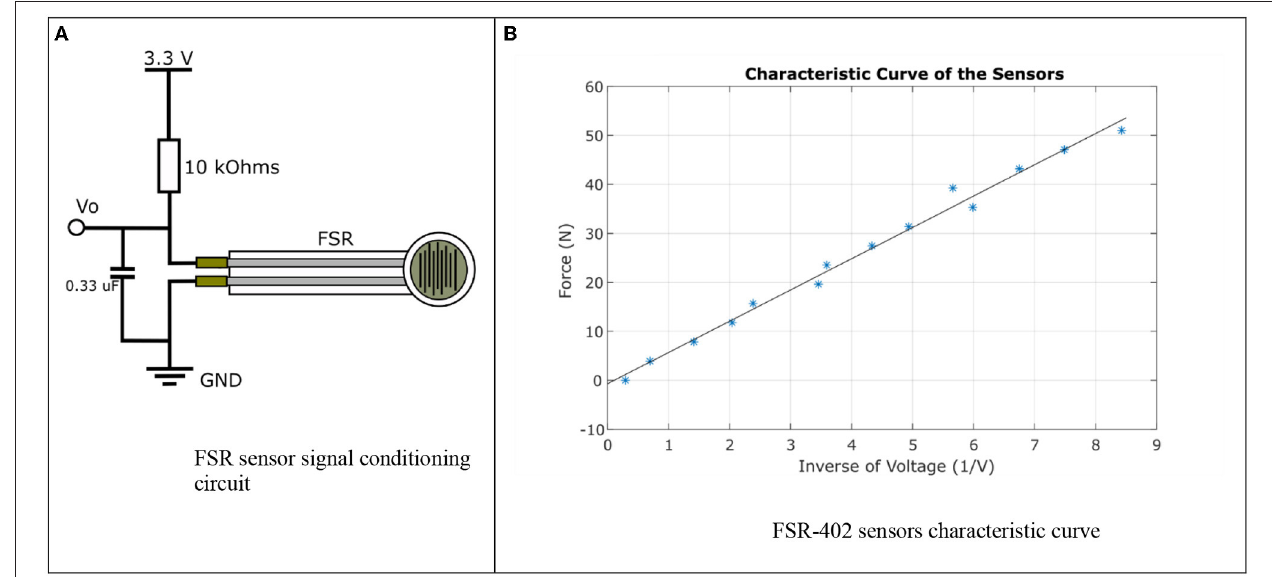
FIGURE 4 | FSR sensors characterization. (A) FSR sensor signal conditioning circuit. (B) FSR-402 sensors characteristic